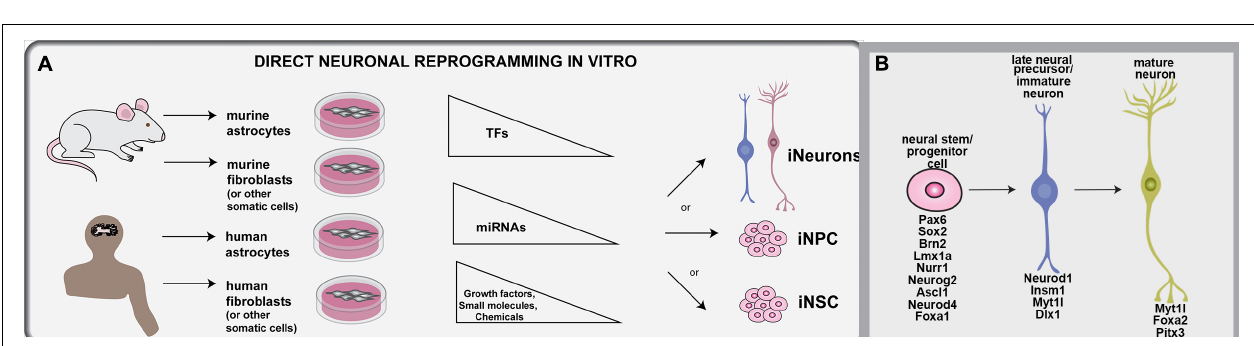
FIGURE 2 | Methodologies used for direct neuronal reprogramming in vitro. (A) Direct neuronal reprogramming involves the direct conversion of somatic cells, usually astrocytes or fibroblasts, either directly into iNs or into iNSCs or iNPCs, which in turn can be differentiated into neurons. (B) Neuronal lineage conversion has been studies in murine and human cells for the most part, and involves the forced expression of lineage specifying transcription factors or miRNAs and the exposure to growth factors and other small molecules and chemicals that can make a pro-neurogenic